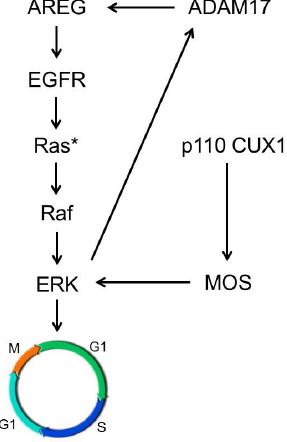
Figure 8. Schematic depiction p110 CUX1 effect on EGFR–MEK-ERK signaling. p110 CUX1 syner- gizes with EGFR-KRAS mut signaling by reinforcing MEK-ERK signaling via upregulation of the EGF ligand sheddase ADAM17 and the serine/threonine kinase MOS.